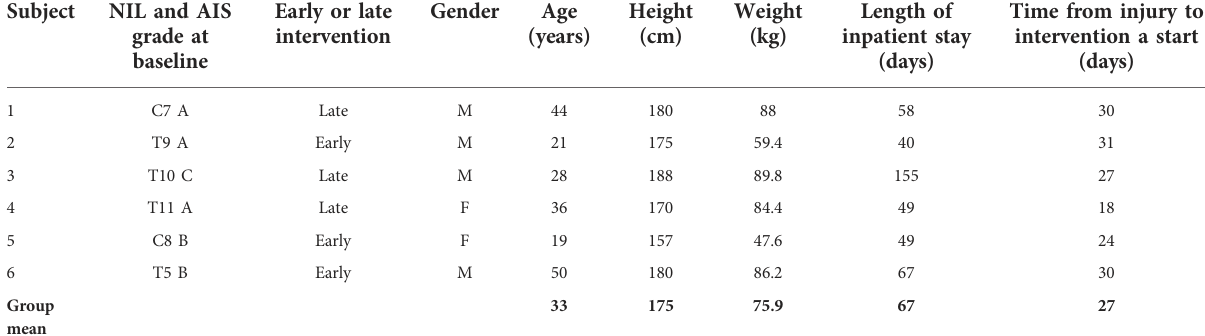
TABLE 1 Demographic information for study participants. NIL, neurological injury level; AIS, american spinal injury association impairment